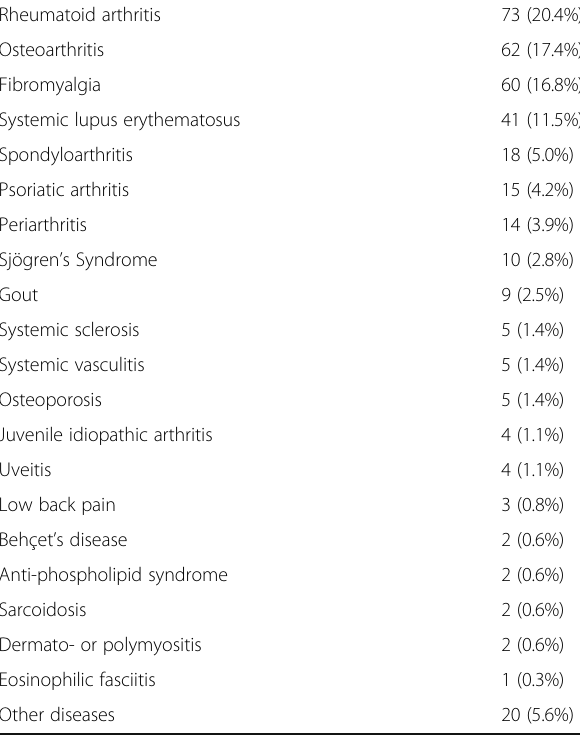
Table 3 Diagnostic hypotheses formulated by the rheumatologist at first consultations ( n =